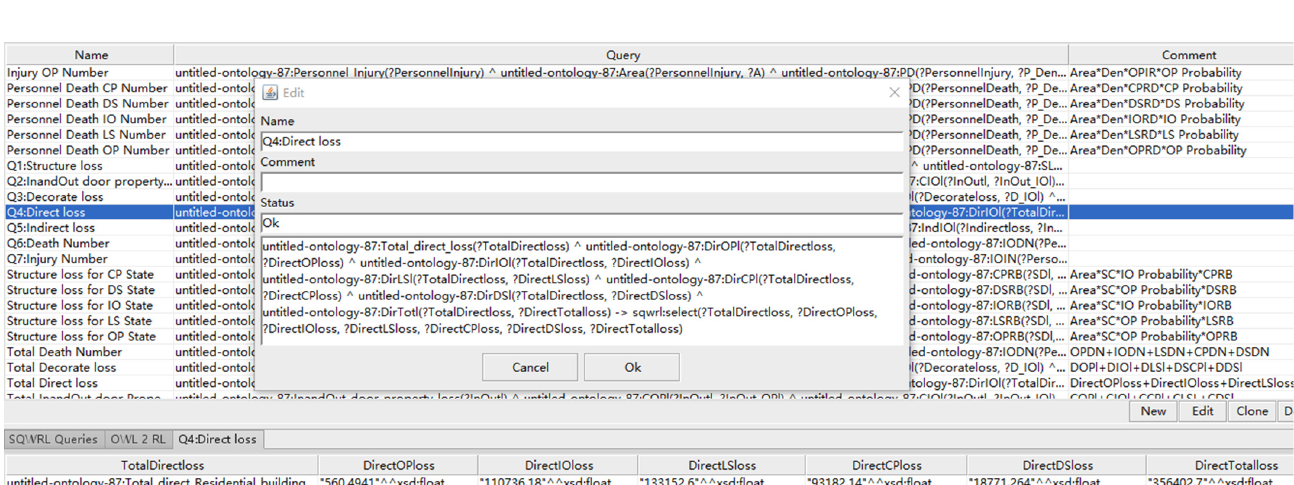
Figure 13. Inference results of querying according to the SQWRL rule Q4 in Table 12.